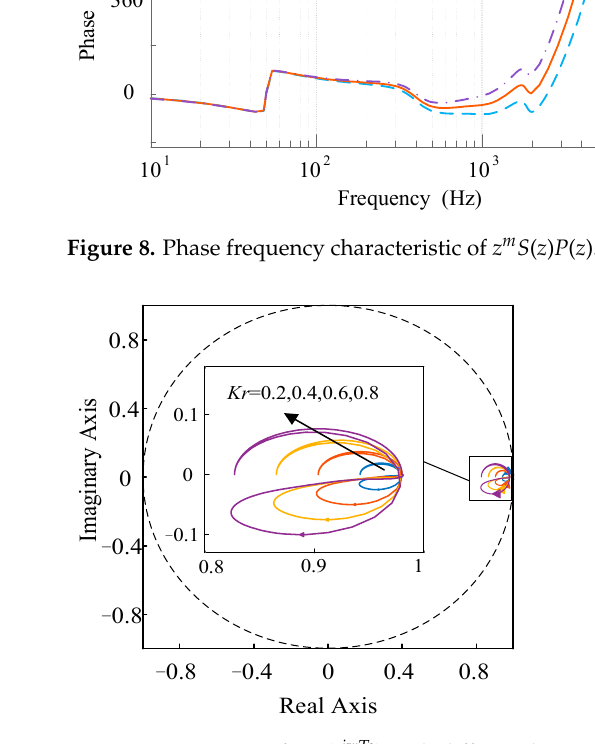
Figure 8. Phase frequency characteristic of z m S ( z ) P ( z ) .